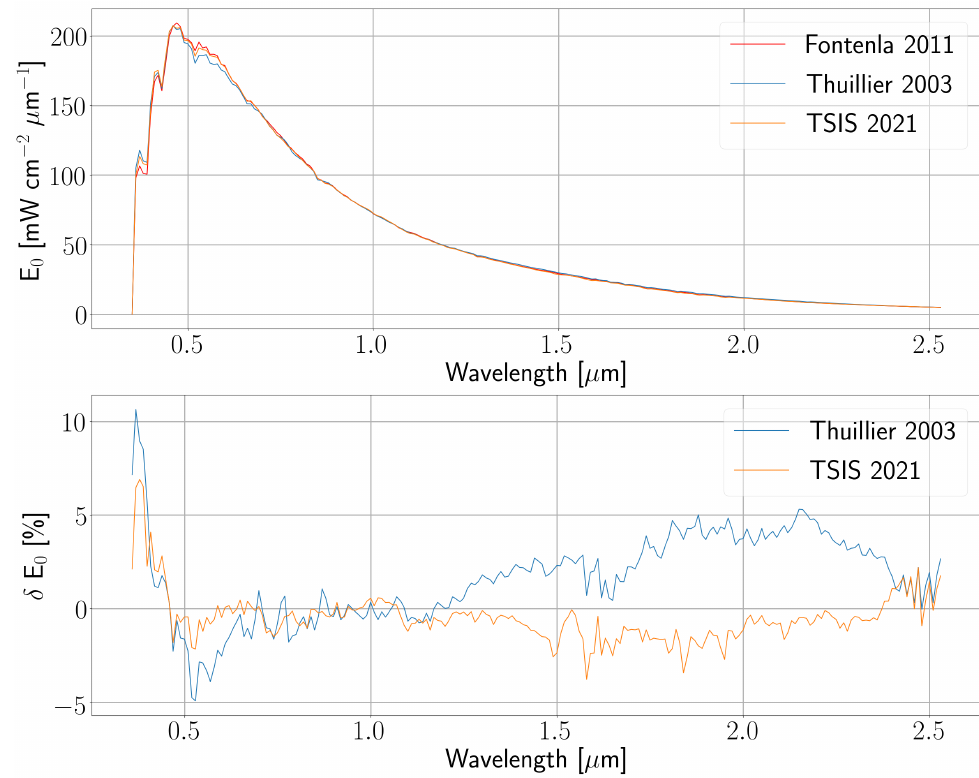
Figure 2. Top : Thuillier (blue), Fontenla (red) and TSIS (orange) solar spectra with a SSD = 10 nm and convolved to a Gaussian SRF with FWHM = 10 nm. Bottom : Relative solar irradiance differences (in %) of Thuillier (blue) and TSIS (orange) with respect to